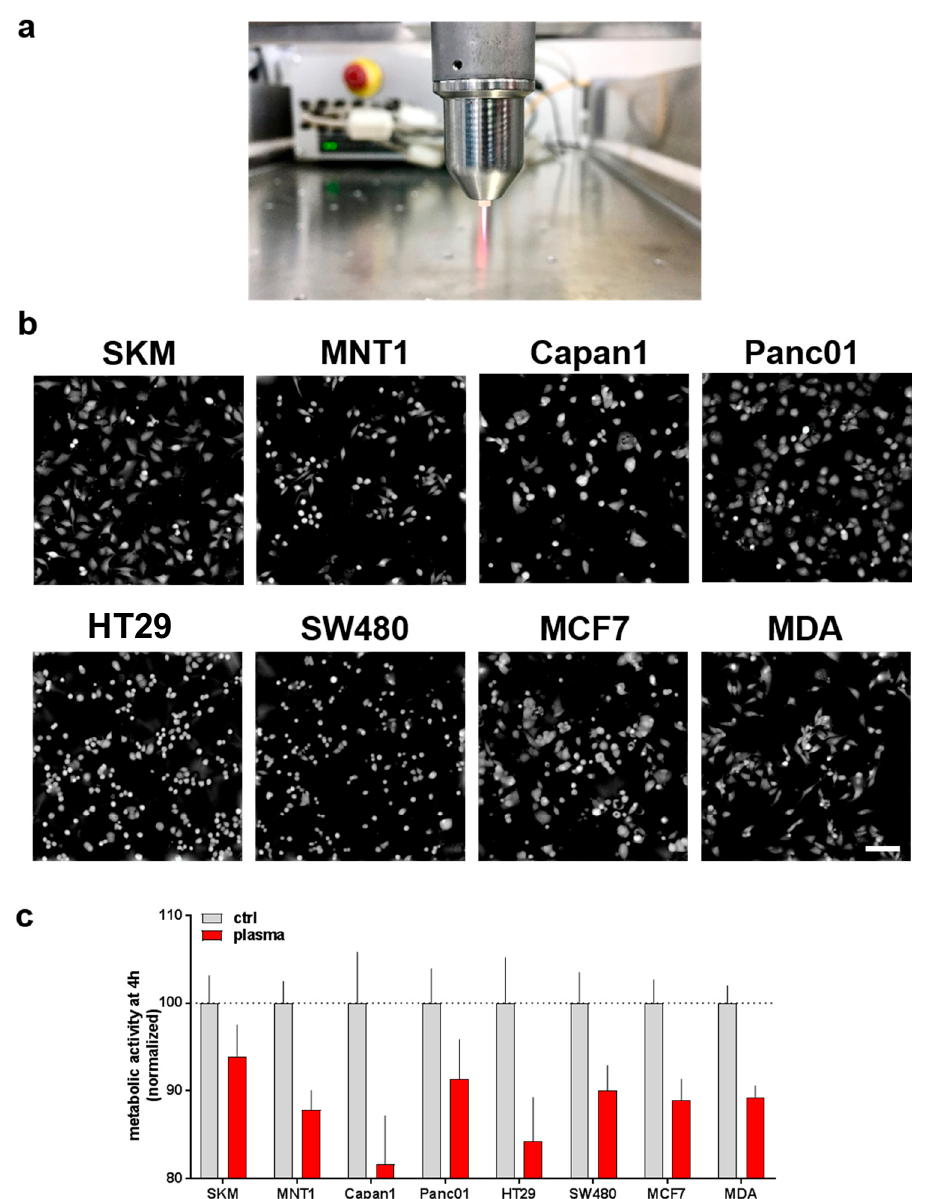
Figure 1. Exposure of initially-seeded 1 × 10 4 cells of eight human tumor cell lines to plasma-treated medium led to a reduction in metabolic activity. ( a ) Representative image of the atmospheric pressure argon plasma jet (kINPen) utilized; ( b ) representative images in digital phase contrast (DPC) mode showing cytosolic fraction of all cell types investigated; ( c ) metabolic activity (as measured using resazurin) 4 h following exposure to control or PTM, data are normalized to that of control medium. Data are from 8 independent experiments with four technical replicates each. Scale bar = 100 µ m. Red bars = plasma-treated medium (PTM); grey bars = untreated medium (control).